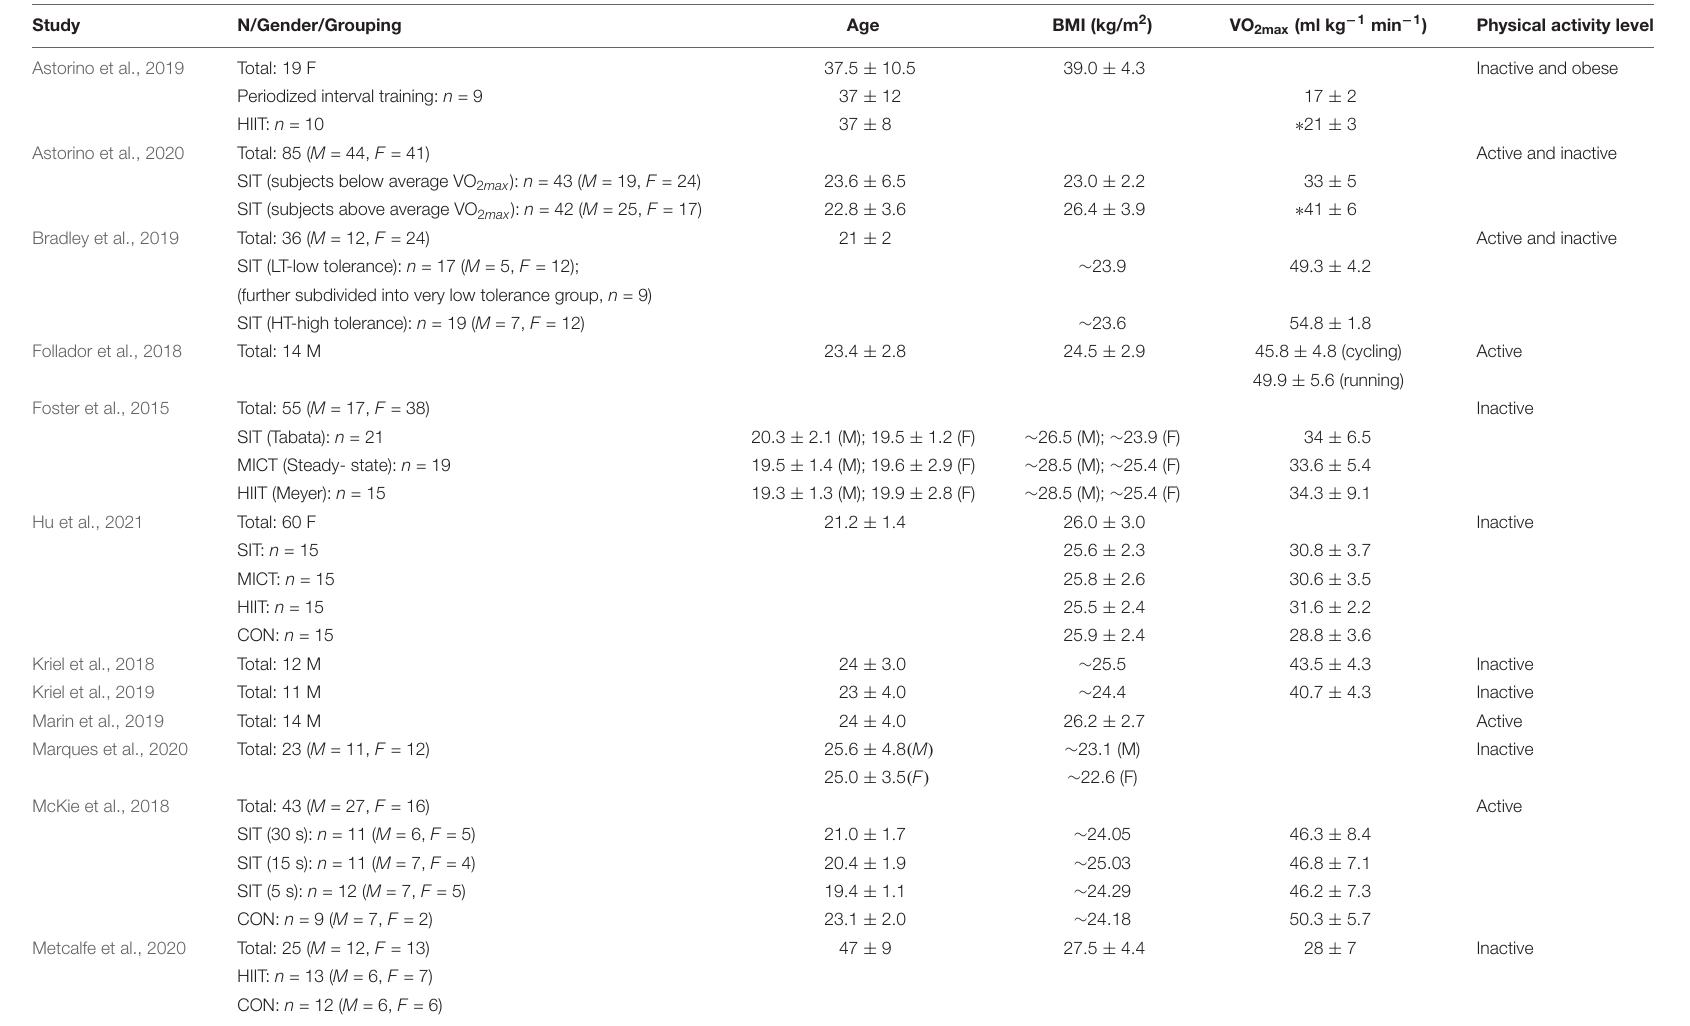
TABLE 1 | Participants’ characteristics of all included